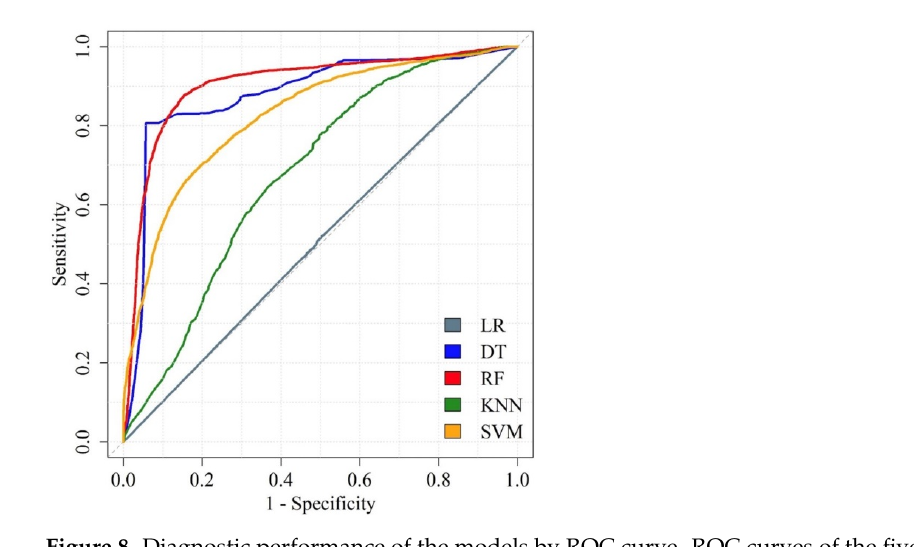
Figure 7. Diagnostic performance of the models. Sensitivity, specificity, accuracy, and area under the receiver operating characteristic curve (AUROC) for the models with various algorithms. Amid the algorithms, RF, and DT outperform other algorithms.